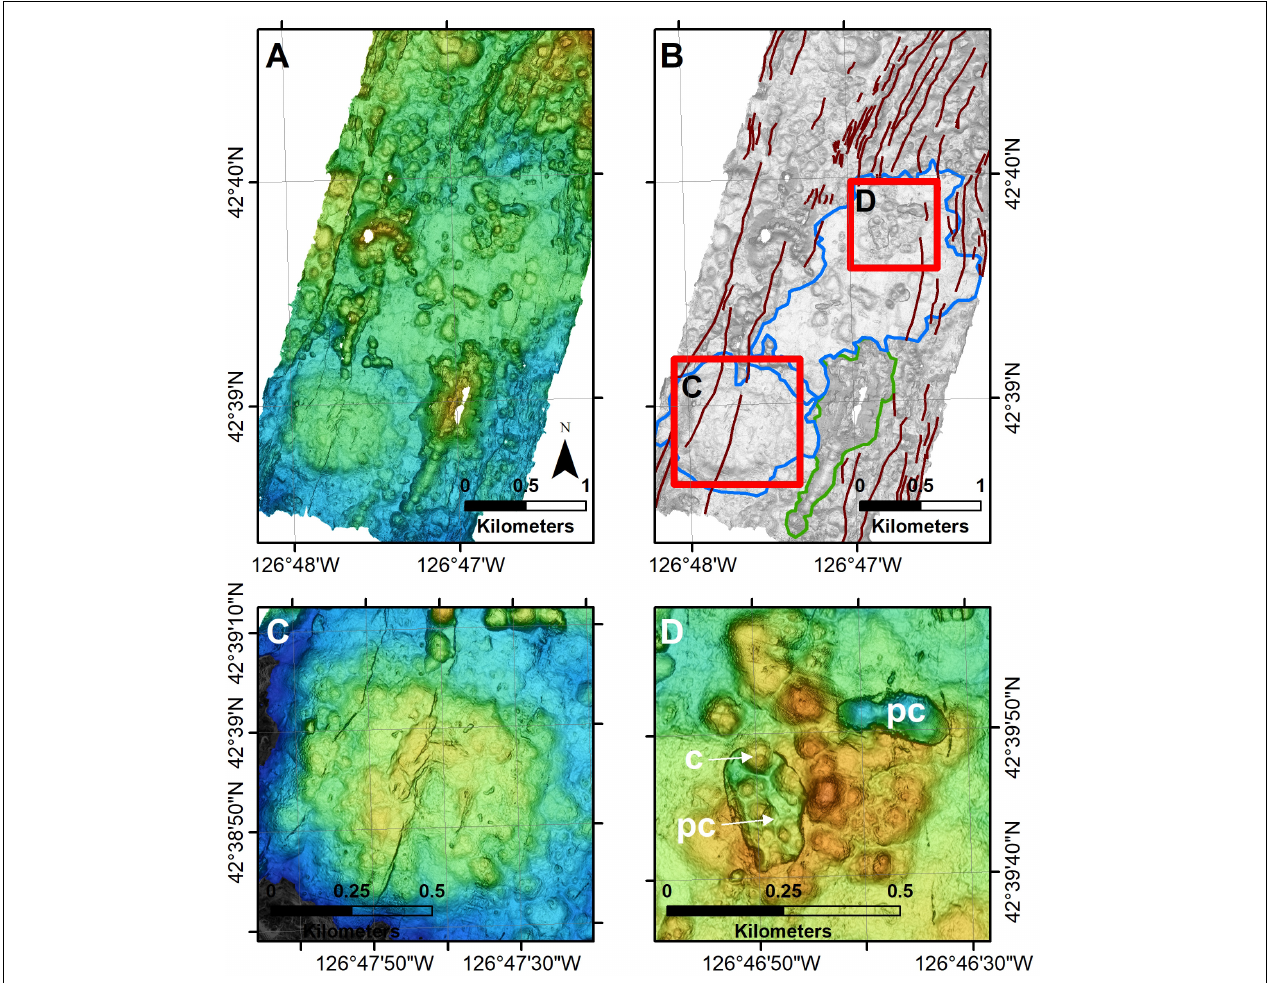
FIGURE 14 | (A) Regional view of inflated hummocky flow, flat-topped cone, and large-volume elongate ridge at southern end of the surveyed area. Color ramp of blue = –3400 m to orange = –2800 m. (B) Same area with blue outlines of flat-topped cone (C) and inflated hummocky flow (D) , and green outline of elongate ridge. Linework of faults showing that they bend eastward around northern inflated hummocky flow. The elongate ridge has abundant syneruptive talus on its lower slopes. Red boxes show the extents of maps in C and D. (C) Summit of flat-topped cone showing cross-cutting fissures, tumuli, channels and small drained lava ponds around a shallow central depression. (D) Close-up of two of seven pit craters on the complex inflated hummocky flow. The pit craters cross-cut some hummocky flow mounds, and younger hummocky flow mounds (north end of southwest crater) bury the ring fault bounding the crater. Both C and D have color ramp of blue = –3225 m to orange = –3075